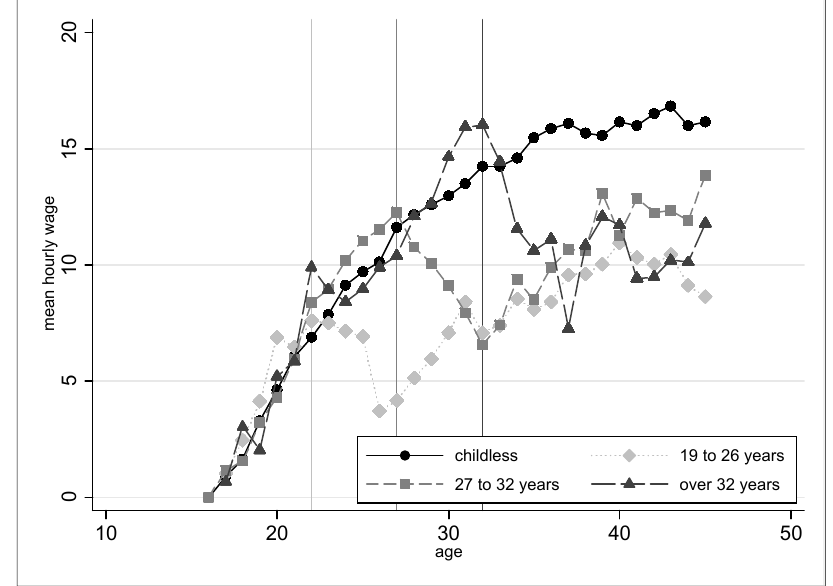
Figure 2 : Development of the mean hourly wage by the biological age at first